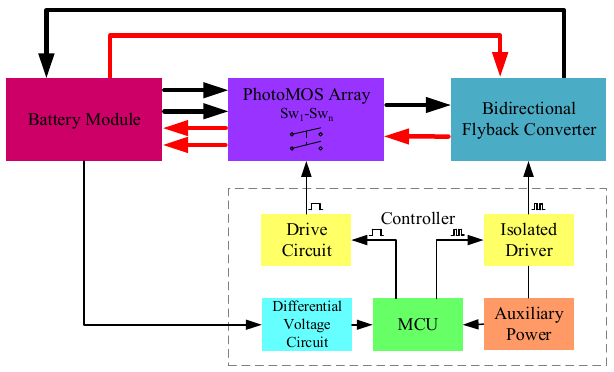
Figure 1. Block diagram of active cell balancing system based on bidirectional flyback converter.